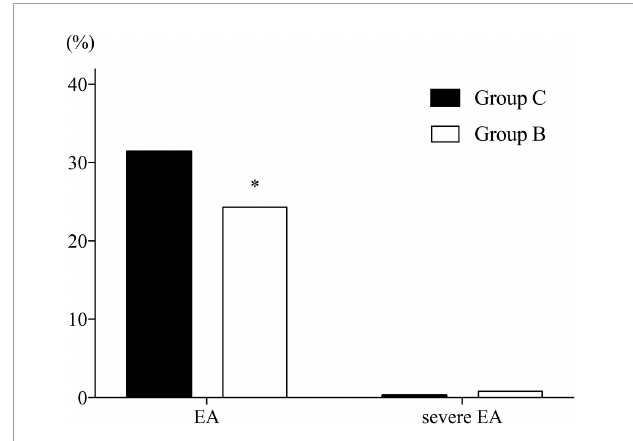
FIGURE2 Incidence of emergence agitation. B, butorphanol; C, control with normal saline; EA, emergence agitation. Emergence is defined as the time spent in post-anesthesia care unit (PACU). Agitation is defined as a sedation–agitation scale score ≥ 5. Severe agitation is defined as